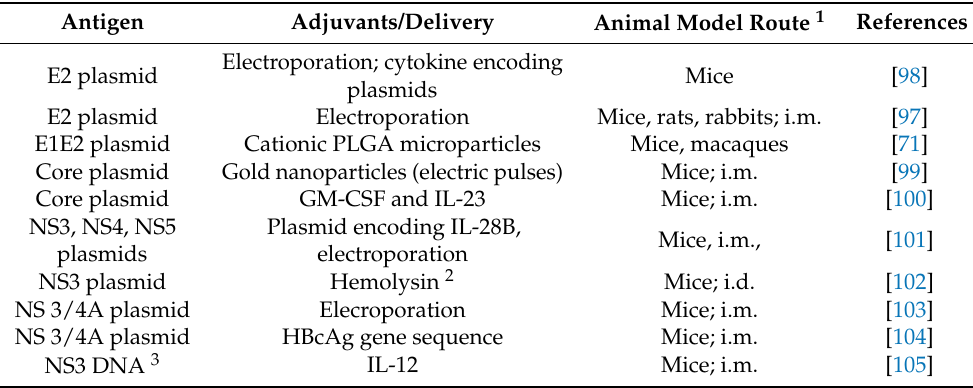
Table 2. Delivery technologies for HCV DNA vaccine candidates.